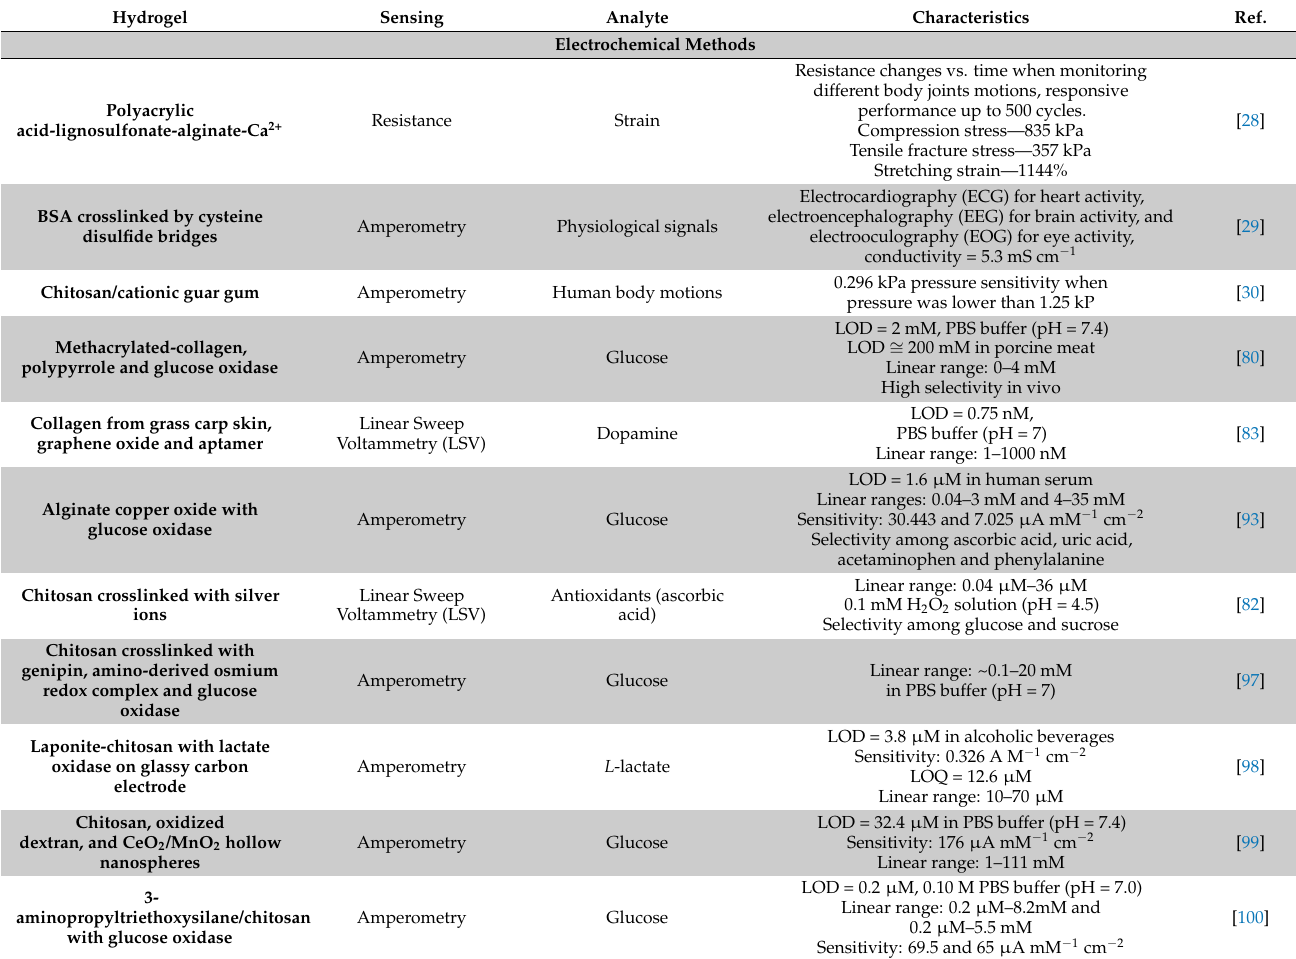
Table 1. Natural hydrogel-based